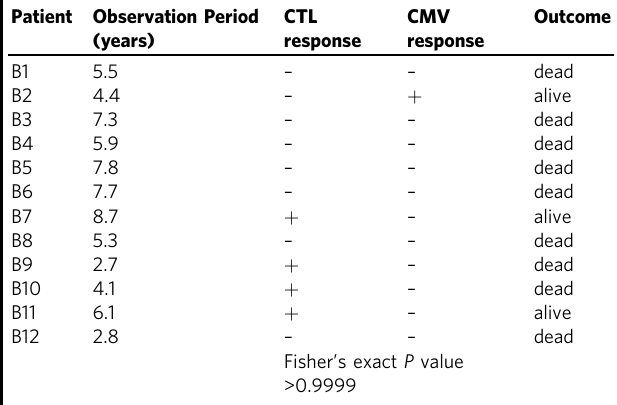
Table 2 Individual survival data of the SART2 peptide vaccine trial.